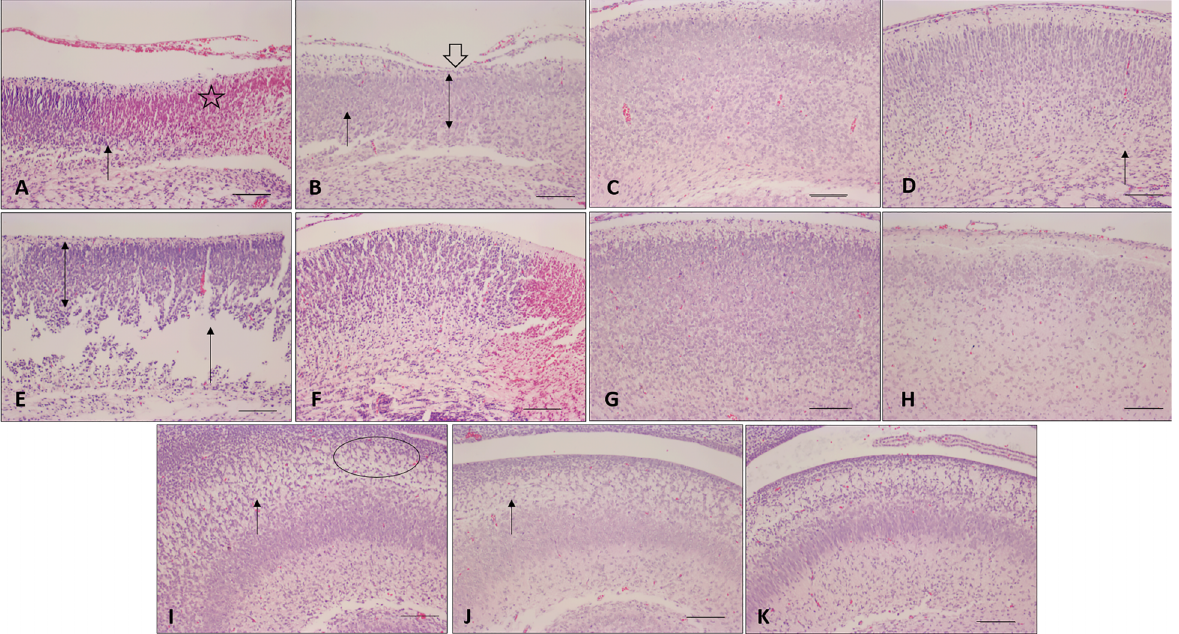
Figure 1. Photomicrographs of histological slides of newborn rat brains. Cerebral cortex: A : preterm asphyxiated rats; B : preterm asphyxiated and ventilated rats; C : preterm control rats; D : preterm ventilated rats; E : term asphyxiated rats; F : term asphyxiated and ventilated rats; G : term control rats; H : term ventilated rats. Hippocampus: I: preterm asphyxiated rats; J : preterm asphyxiated and ventilated rats; K : preterm control rats. Note the mild cortical disorganization (arrows), vacuolization area (circles), midbrain bleeding (star), reduction of cortical volume (double arrows), reduction of molecular layer, scar injury extended from the dorsal cortex (open arrow), with loss of gray matter areas. Hematoxylin and eosin. Magni fi cation: 10 (cid:1) ; scale bar: 100 m